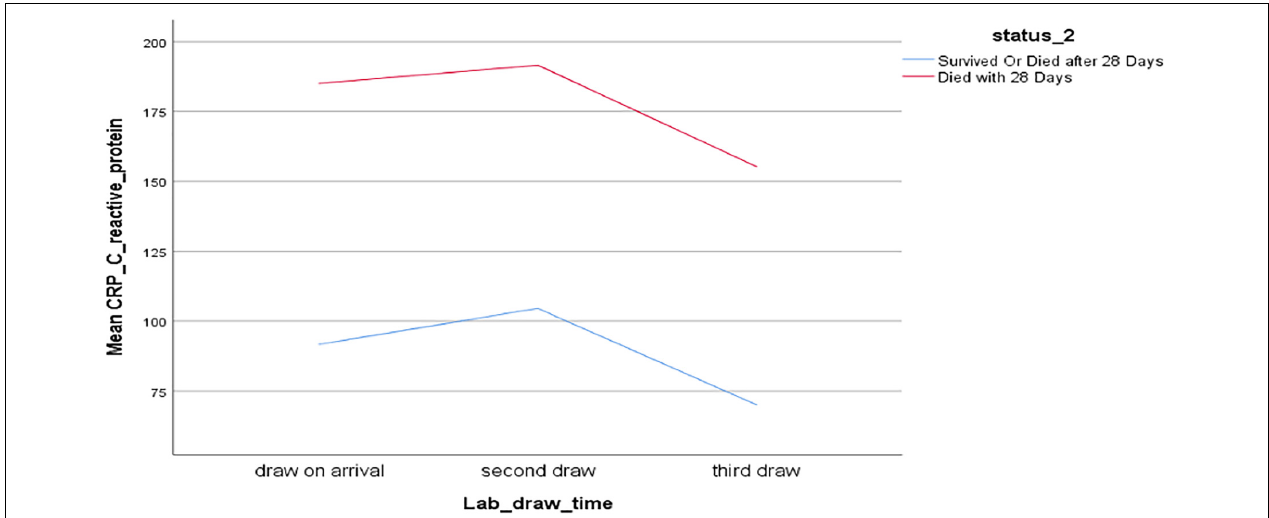
FIGURE 2 | Mixed model analysis of C-reactive protein (mg/dL), time of blood draw, and survival.